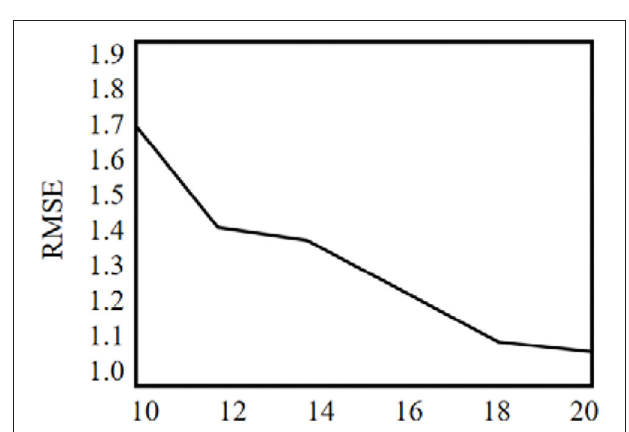
FIGURE 11 | The effect of hash functions number on the RMSE